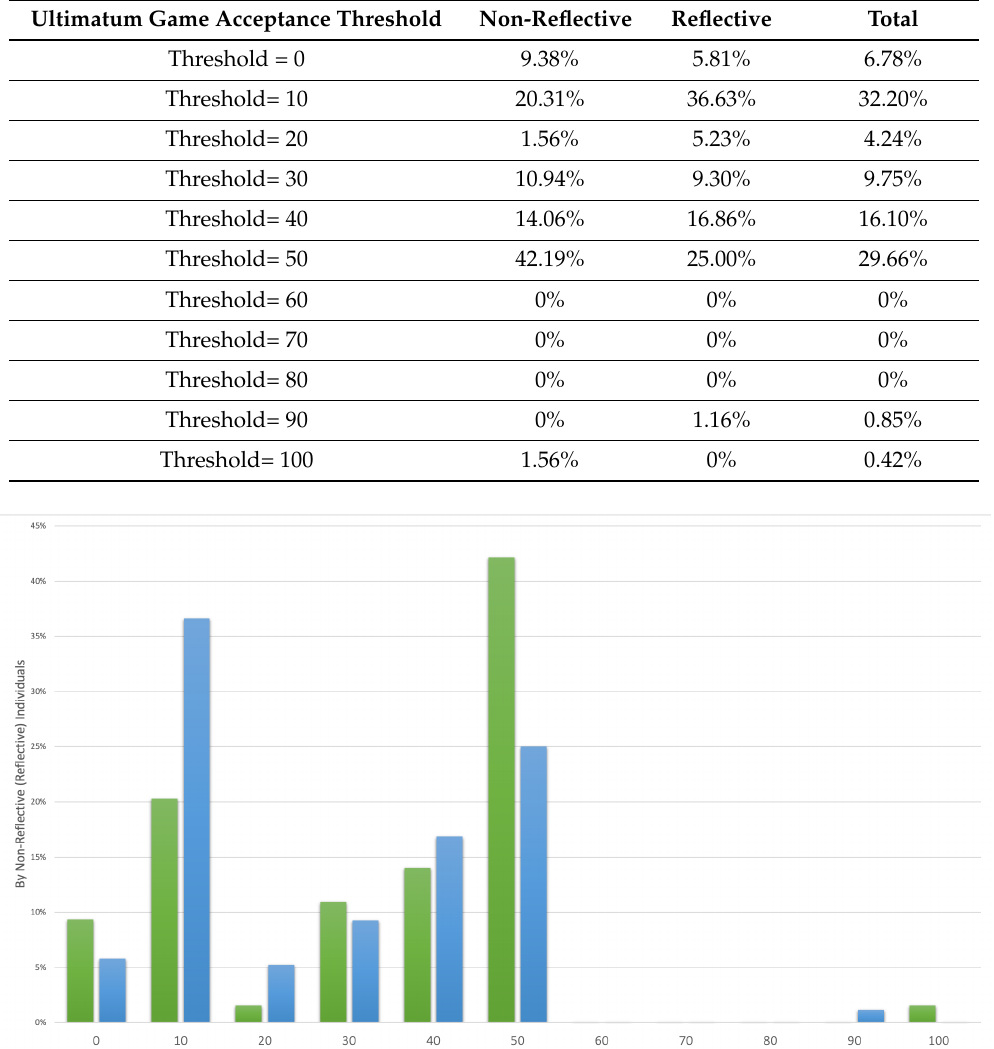
Table A14. FrequencyofUltimatumGameAcceptanceThresholdbyNon-Reflective(Reflective)Individuals.